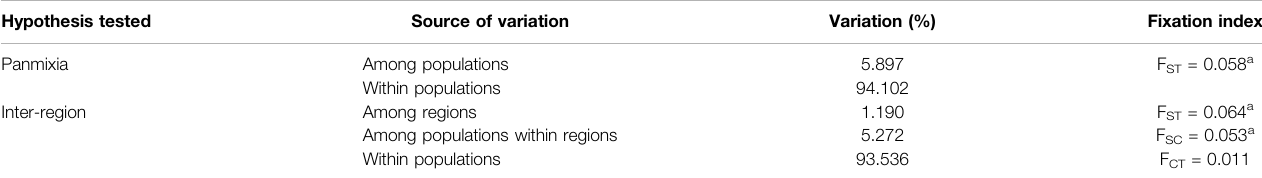
a Indicates statistical signi fi cance at p < 0.05.